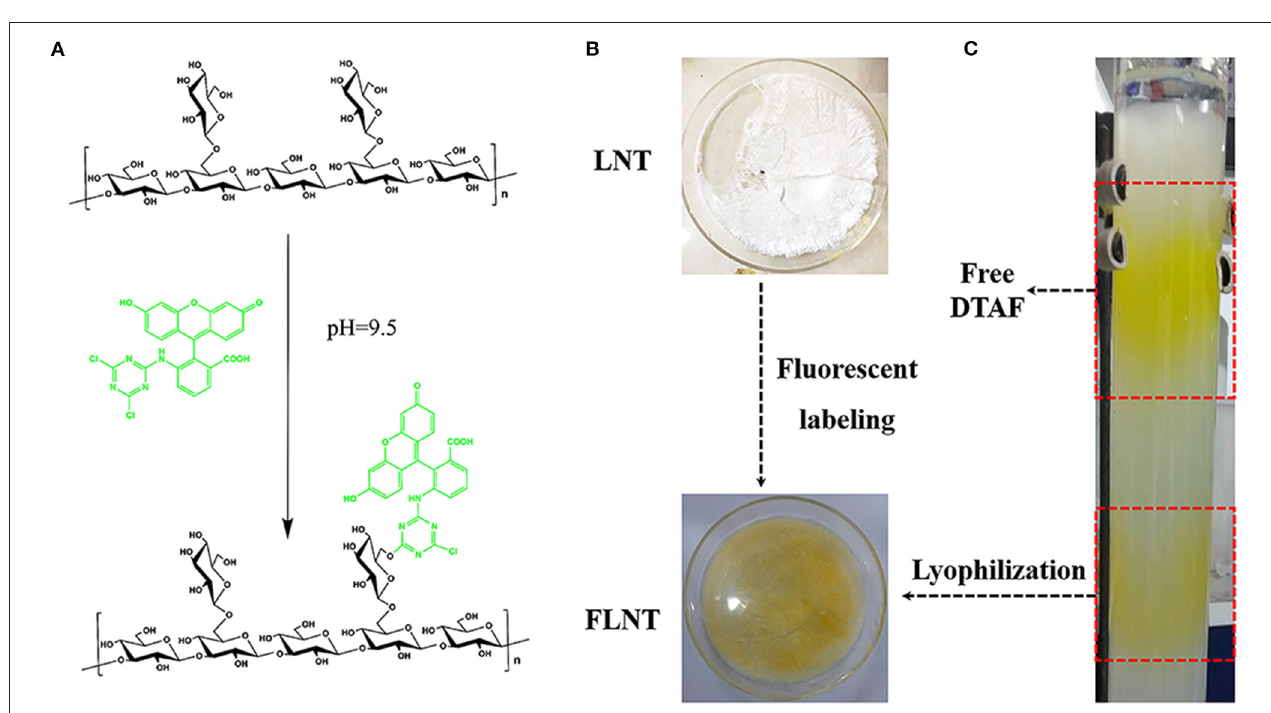
FIGURE 2 | Synthesis of fluorescently labeled lentinan (FLNT). (A) Scheme of LNT and 5-([4,6-Dichlorotriazin-2-yl]amino)fluorescein (DTAF) reaction. (B) The picture of LNT and FLNT. (C) The reaction solution was purified by the Sephadex G-50 column.